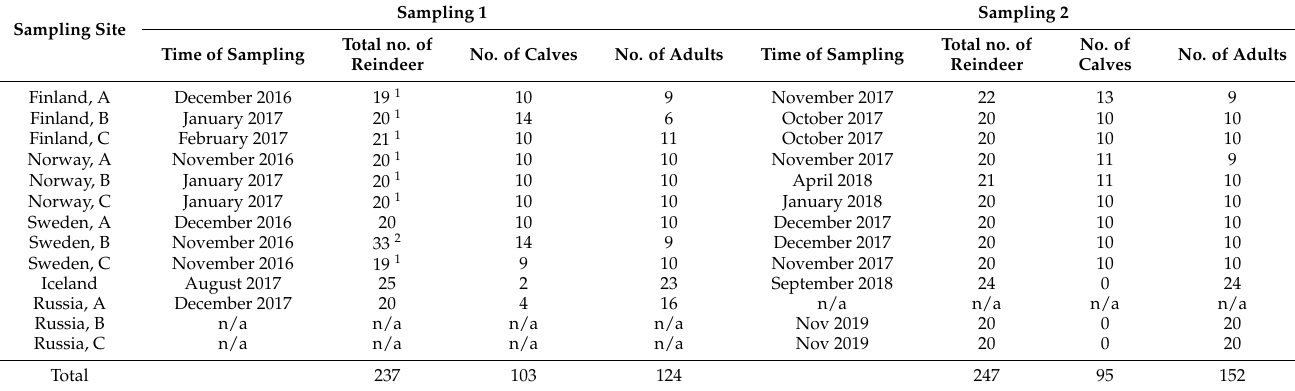
Table 2. Details of the 623 nasal swabs obtained from 484 Eurasian tundra reindeer ( Rangifer t. tarandus ), including calves ( ≤ 1 year) and adult animals (>1 year), in Finland, Norway, Sweden, Iceland, and Russia. Swabs were taken from three geographically separate herds in each country except for Iceland, where the wild reindeer population was sampled. Sampling Site